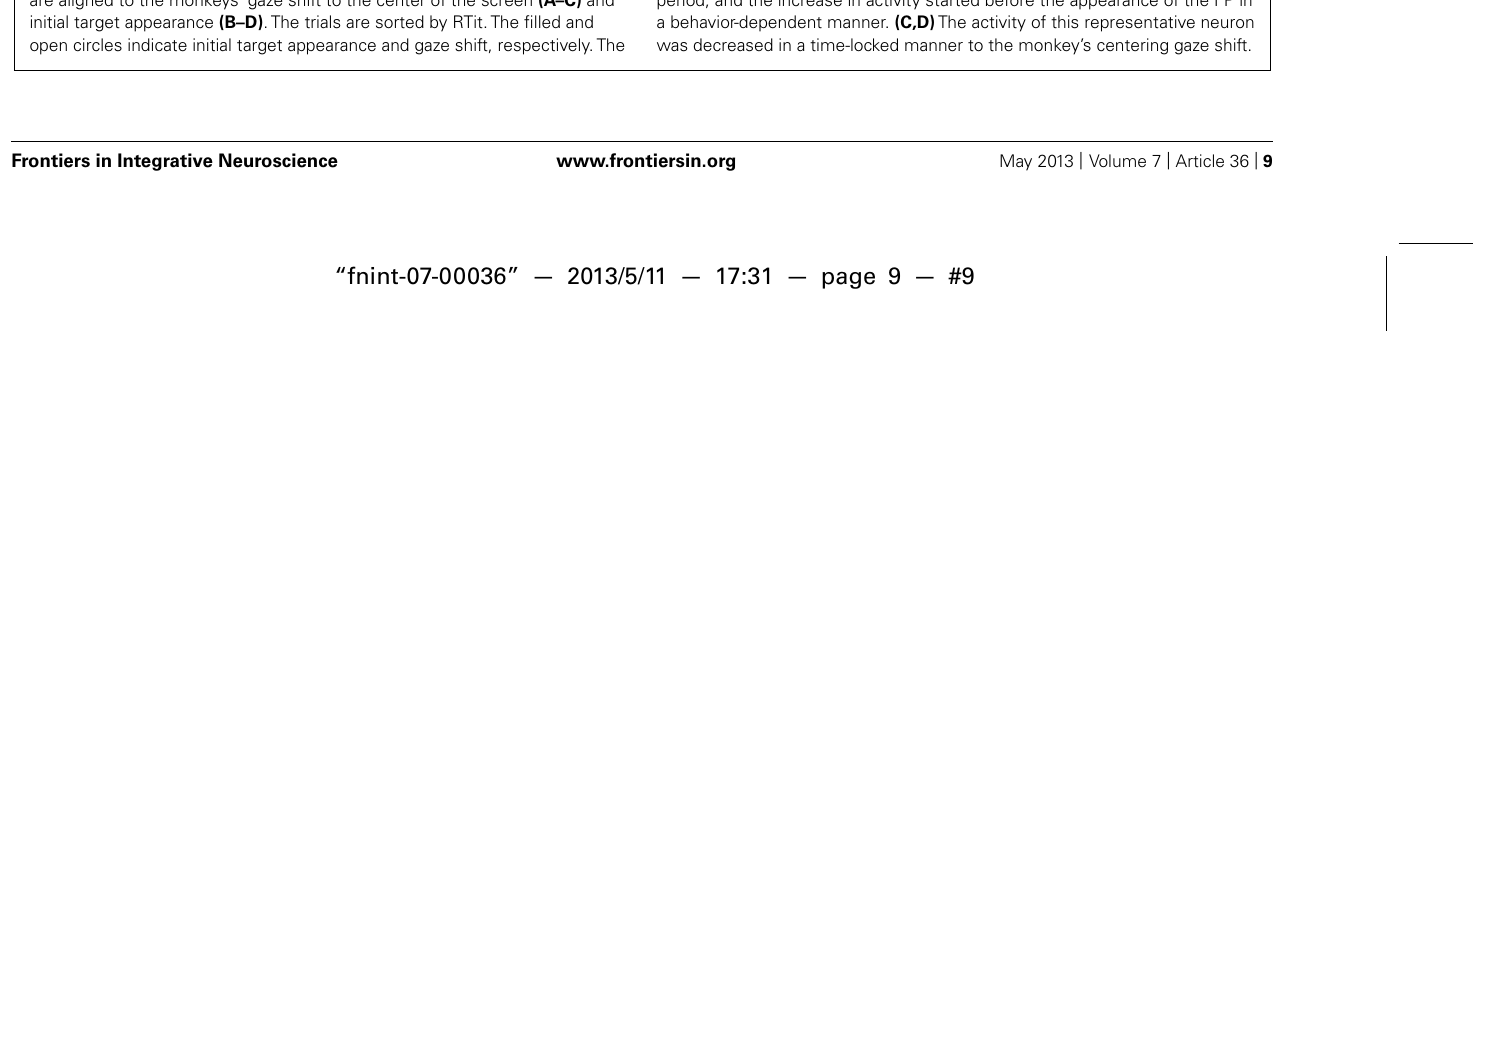
colored rasters and traces indicate the short RTit trials (purple), long RTit trials (green), large reward trials (red), and small reward trials (cyan). (A,B) This representative neuron exhibited an increase in tonic activity during the task period, and the increase in activity started before the appearance of the FP in a behavior-dependent manner. (C,D) The activity of this representative neuron was decreased in a time-locked manner to the monkey’s centering gaze